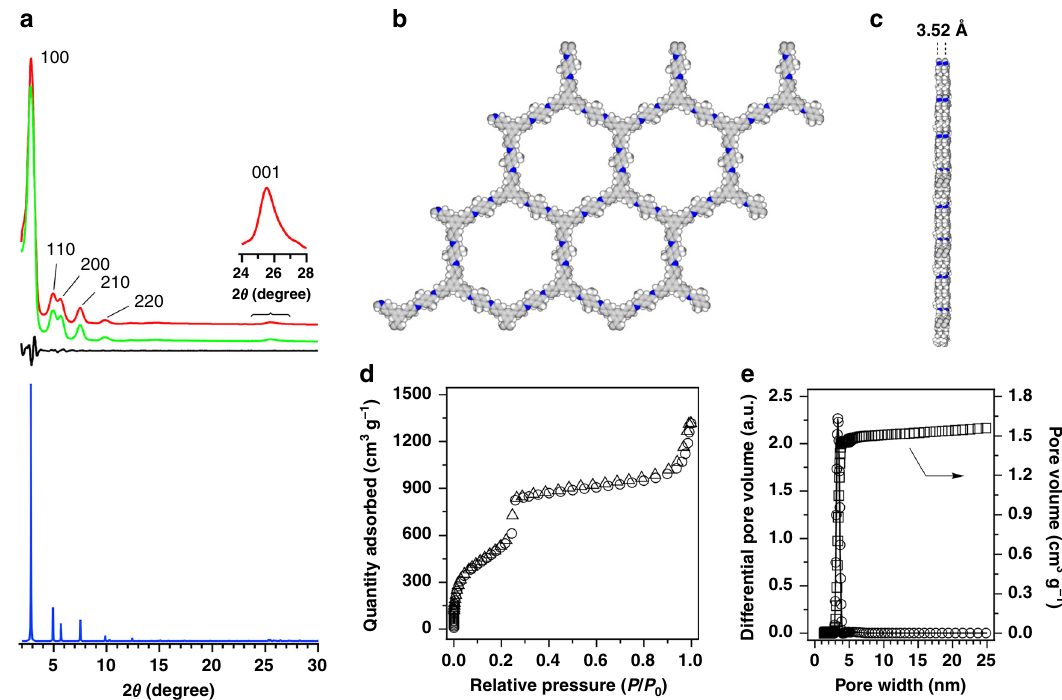
Fig. 2 Crystallinity and porosity. a PXRD patterns of TPB-DMeTP-COF (red curve), the Pawley re fi nement result (green curve) and their difference (black curve), the AA-stacking mode of the P 6 space group (blue curve). b, c Reconstructed crystal structure of (b) top and (c) side views. The 2D layers are stacked at a 3.52-Å interval along the z direction. d Nitrogen sorption isotherms of TPB-DMeTP-COF measured at 77 K (circle, adsorption; triangle, desorption). e Pore size distribution (circles) and pore volume (squares) pro fi